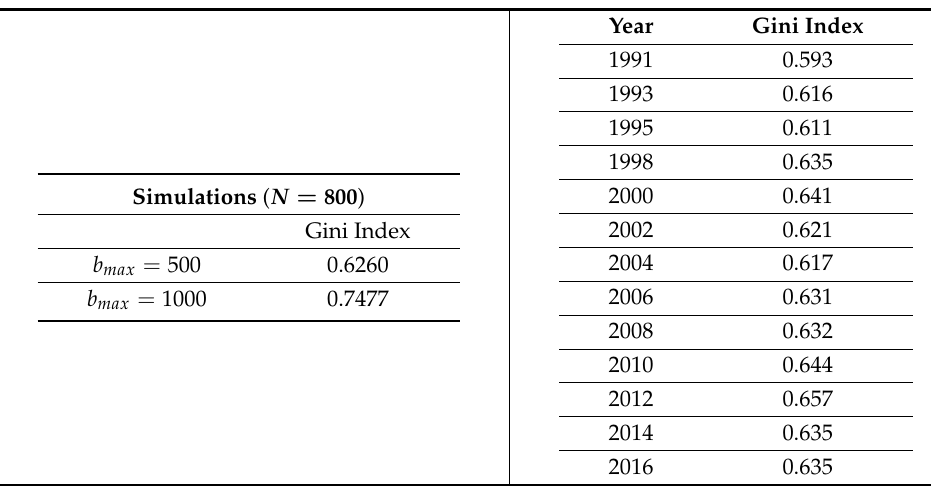
Table 1. Gini index at the end of the sequence of simulated transactions for N = 800 and b max = 500,1000 (on the left), and (on the right) Gini index of per capita net wealth distribution in Italy in the period 1991–2016 (source: Bank of